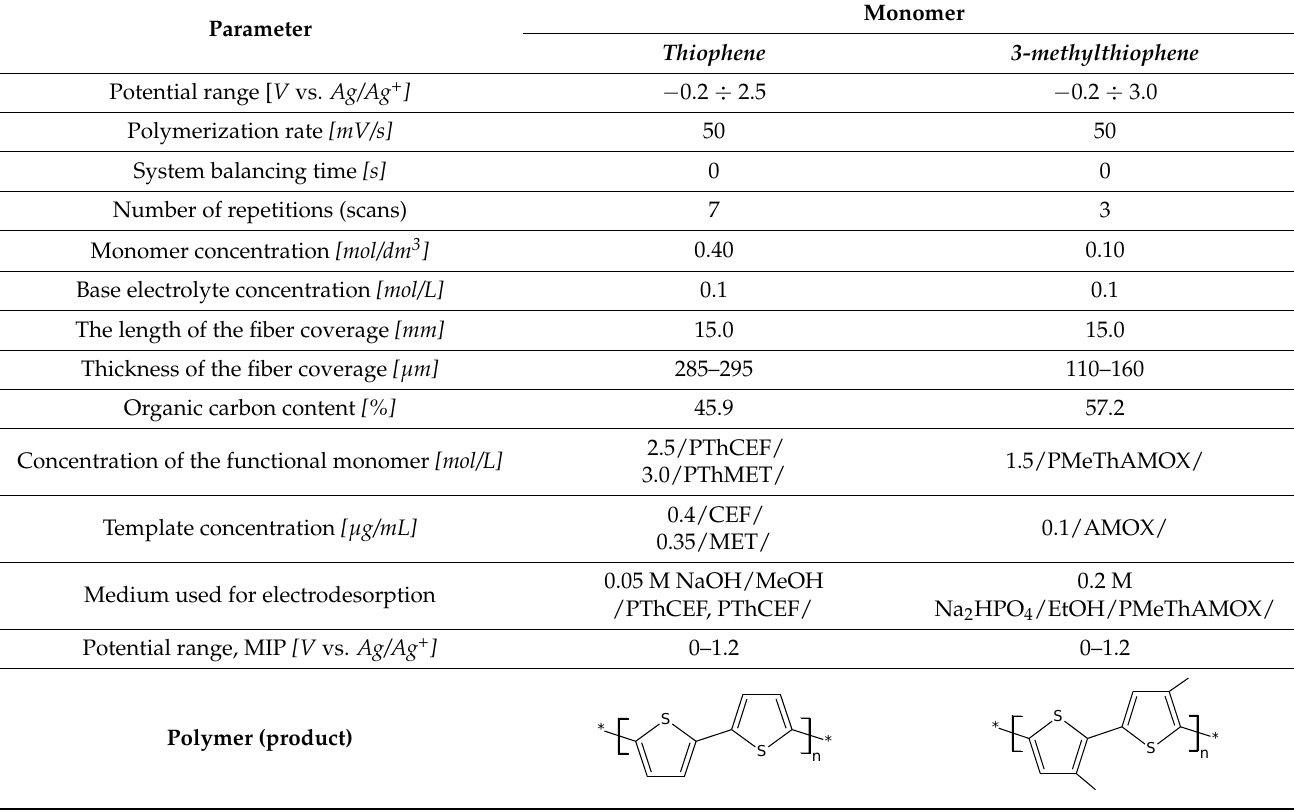
Table 1. Parameters of the electrochemical synthesis of polythiophene and poly(3-methylthiophene) coatings. Parameter.